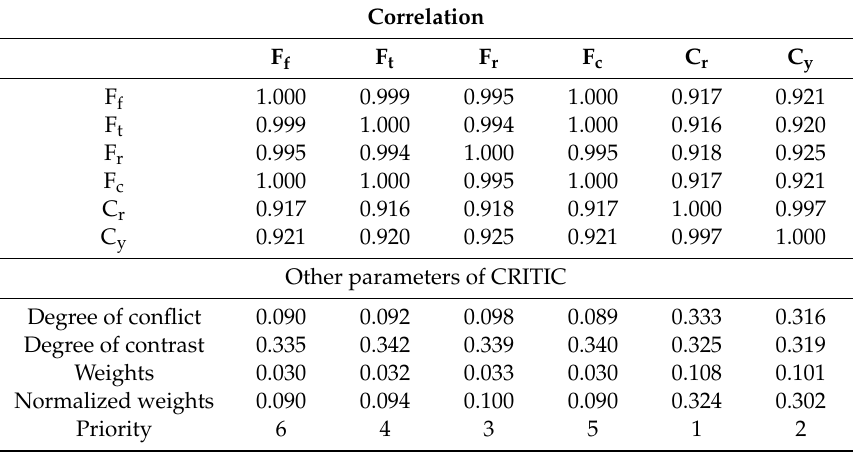
Table 11. Correlation of responses and weights based on CRITIC.